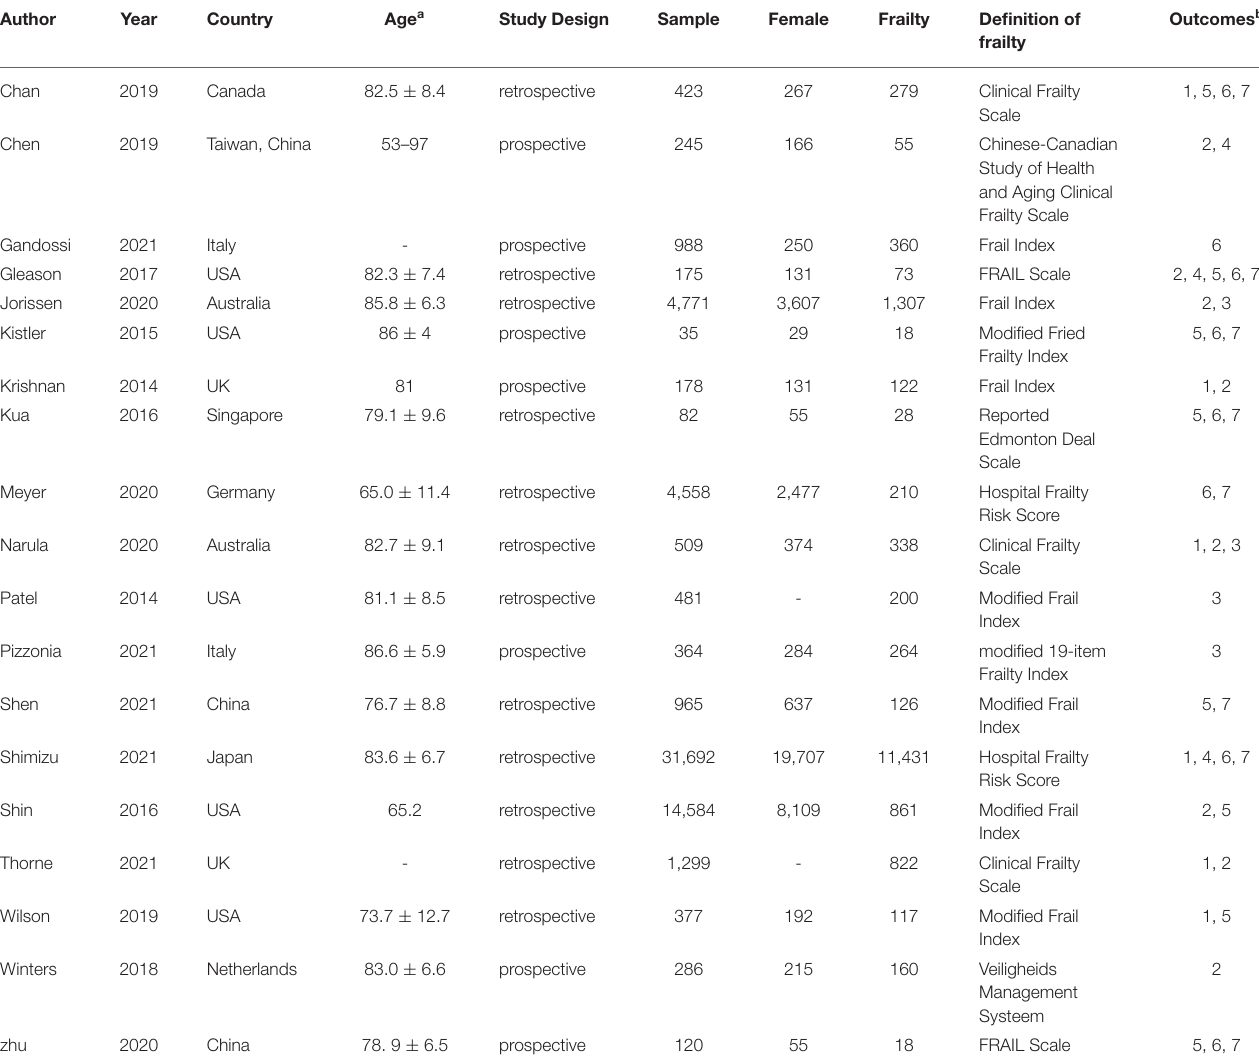
TABLE 1 | Characteristics of included